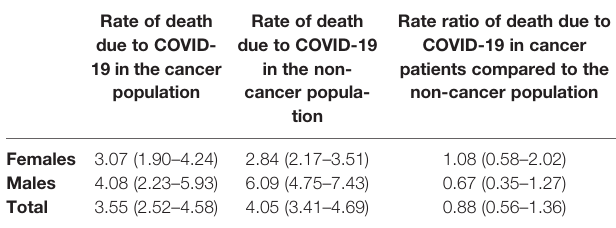
TABLE 3 | Age-standardized cumulative rates of death due to COVID-19 among all cancer patients compared to the non-cancer population (per 100 000). Rate of death due to